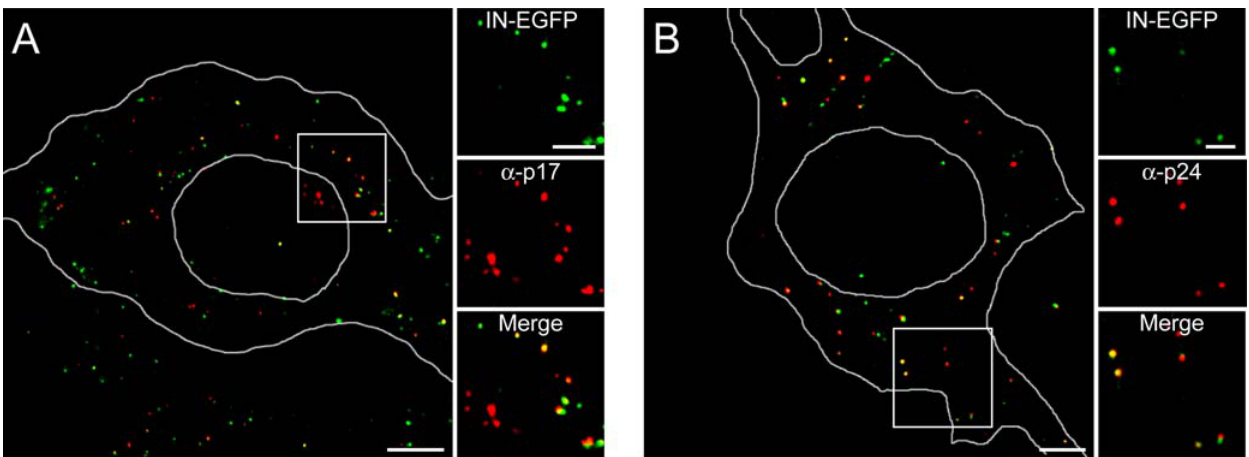
Figure 3. HIV-IN-EGFP virions can be visualized in infected cells. (A) Confocal visualization of HeLa cells infected with concentrated supernatants derived from cells transfected with the pD64E, pVpr-IN-EGFP and pVSV-G plasmids. Six hours post-infection cells were immunostained with antibodies against p17 MA and visualized for EGFP fluorescence (green) or p17 MA staining (red). In the merged image, where cell and nuclear shapes are outlined in white, yellow spots indicate full overlapping of green and red signals. Bar, 5 m m. Enlargements of the boxed region show individual color and merged images. Bar, 2 m m. (B) Same as in (A) using antibodies against p24 CA .